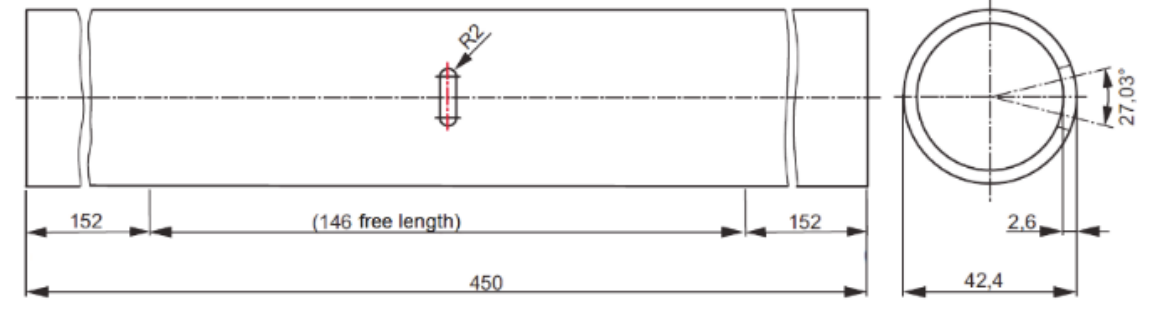
Figure 1: Specimen geometry